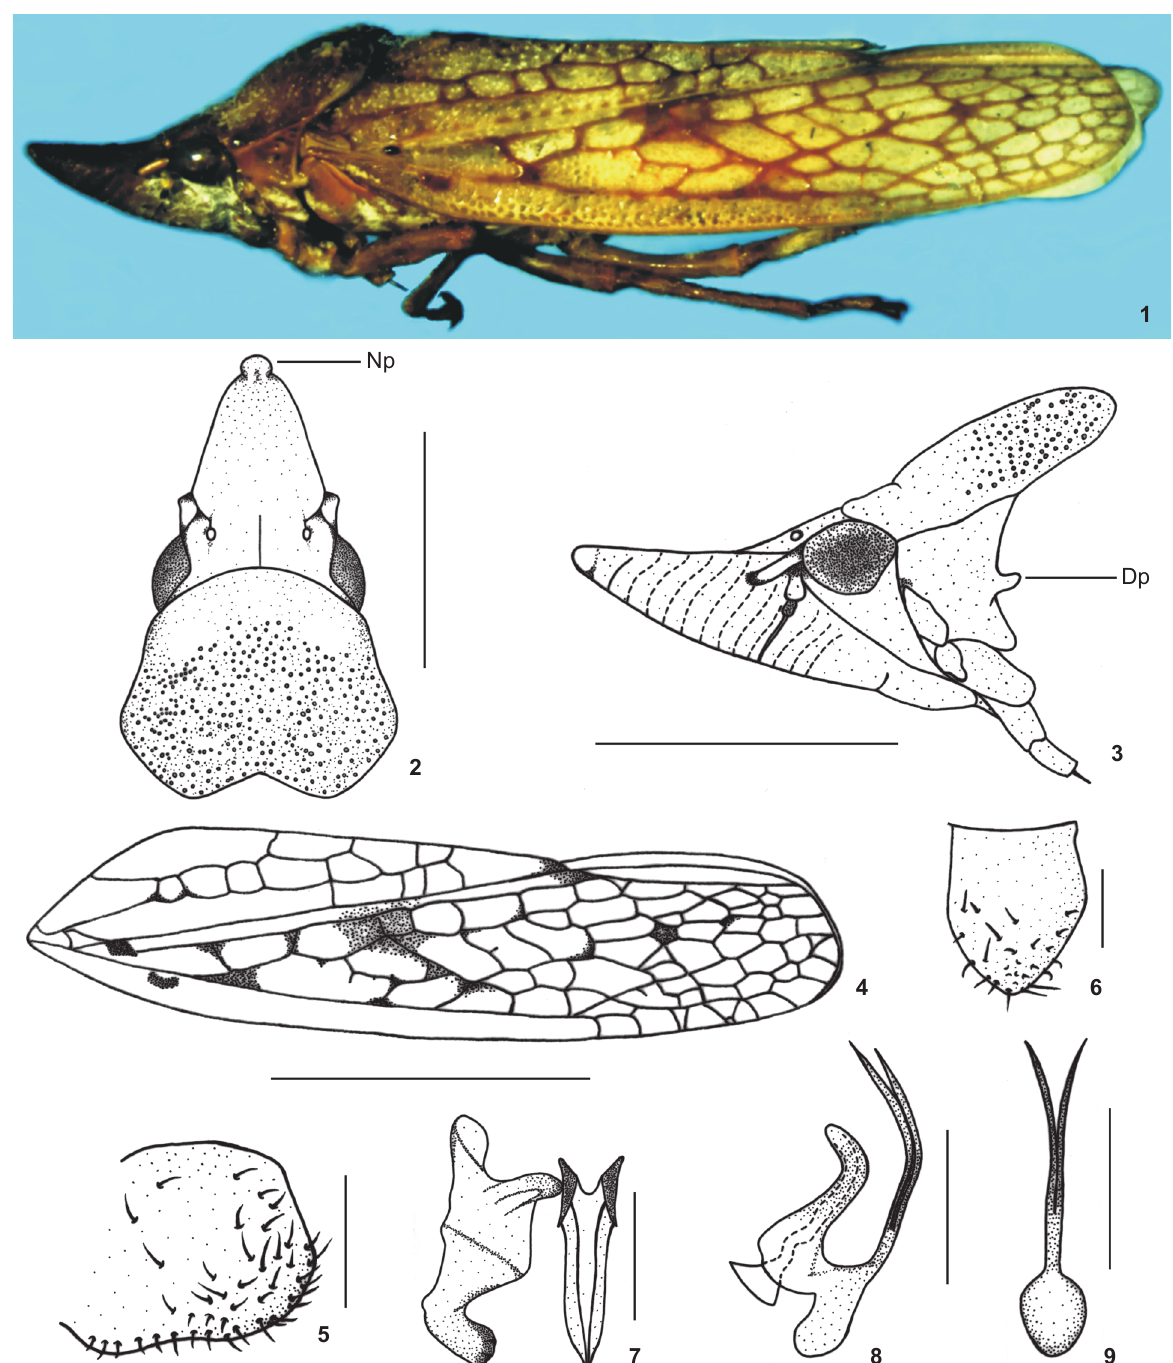
Figures 1-9. Diestostemma nasutum : (1) male, body in lateral view, length 16.8 mm; (2) head and pronotum, dorsal view; (3) head and prothorax, lateral view; (4) forewing; (5-9) male genitalia: (5) pygofer, lateral view – basal portion damaged; (6) subgenital plate, ventral view; (7) style and connective, dorsal view; (8) aedeagus, lateral view; (9) basiventral aedeagal process, ventral view. (Dp) Digitate process, (Np) nose-like process. Scale bars: 2-3 = 3.0 mm, 4 = 5.0 mm, 5-9 = 0.5